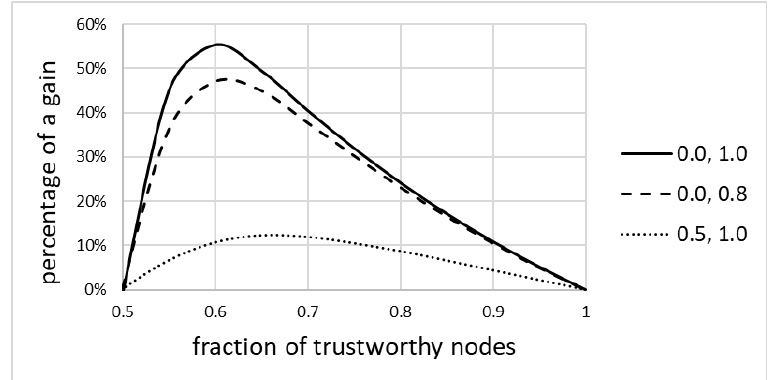
Figure 5. Fractional gain resulting from the use of the model.